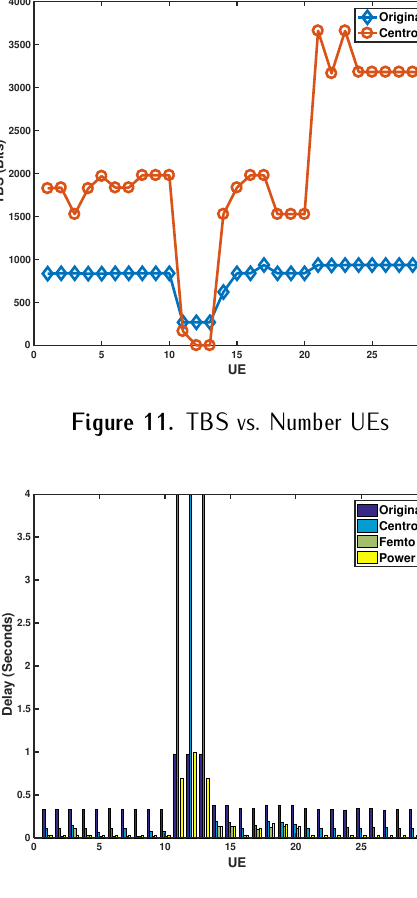
Figure 13. Delay vs. Number UEs Figure 14. Standard Deviation of Delay vs. Number UEs